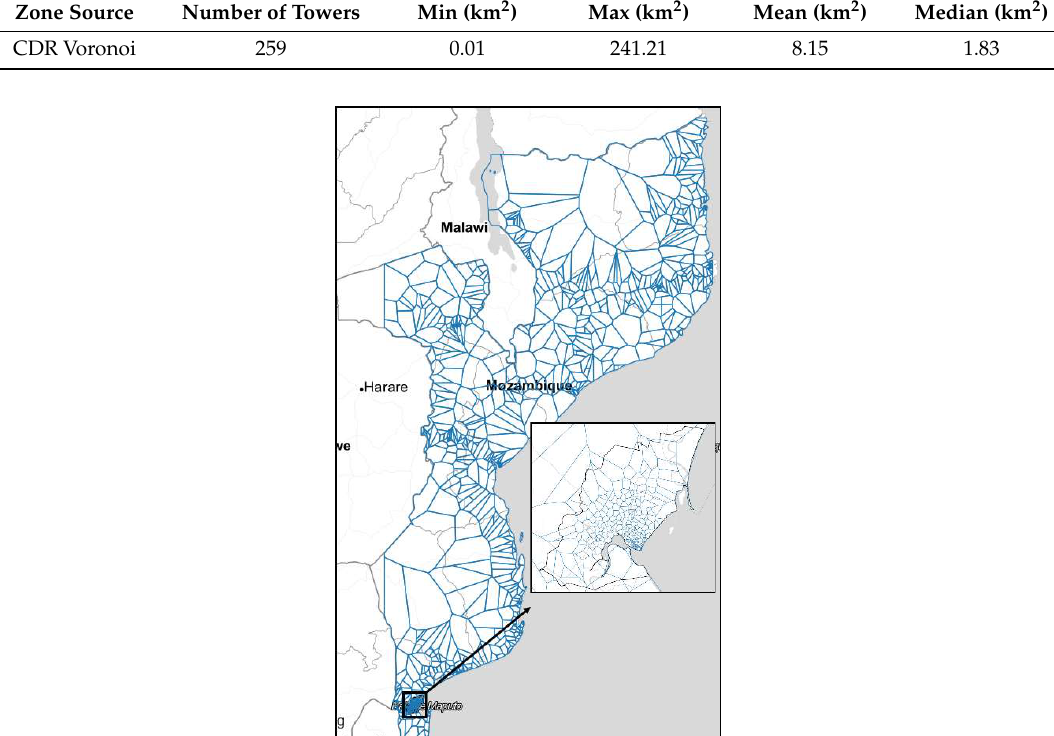
Table 3. Statistical summary of Voronoi zones in the study area.